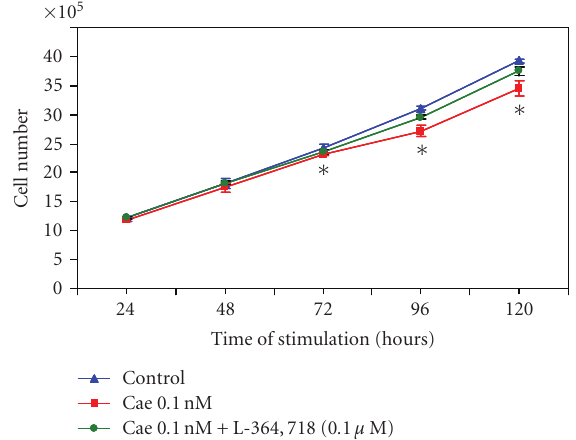
Figure 2: Growth control of the RIN-14B cells by the CCK-1 receptor agonist caerulein (Cae) and the receptor’s specific antagonist, L- 364718. Cells were grown for up to 120 hours in the presence of 0.1nM caerulein ± 0.1 μ M L-364718. Medium and drugs were changed daily and cells were counted daily for up to 5 days. In this experiment, results represent data collected from two separate experiments with four wells per group; overall they represent 8 di ff erent wells in each group. ∗ Significantly di ff erent than control at P < .